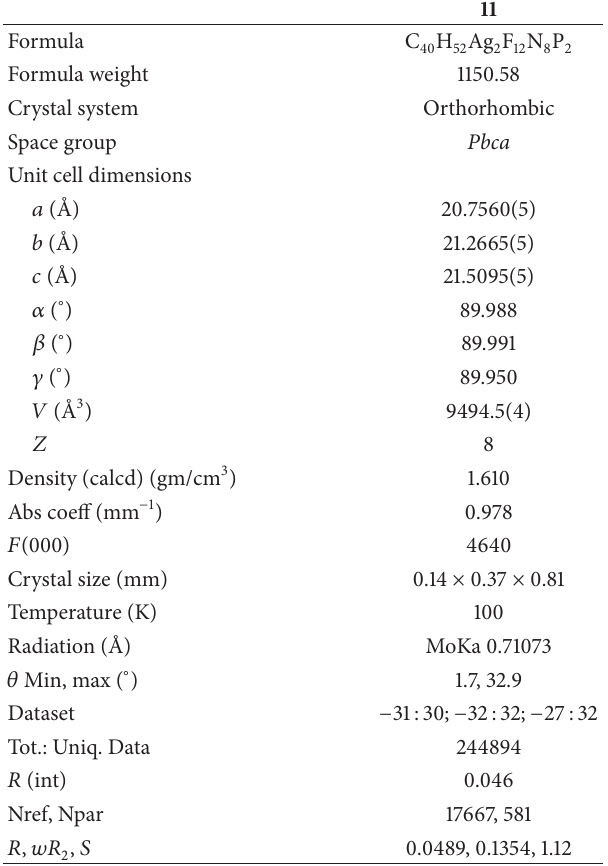
Table 1: Crystal data and structure refinement details for Ag-NHC complex 6